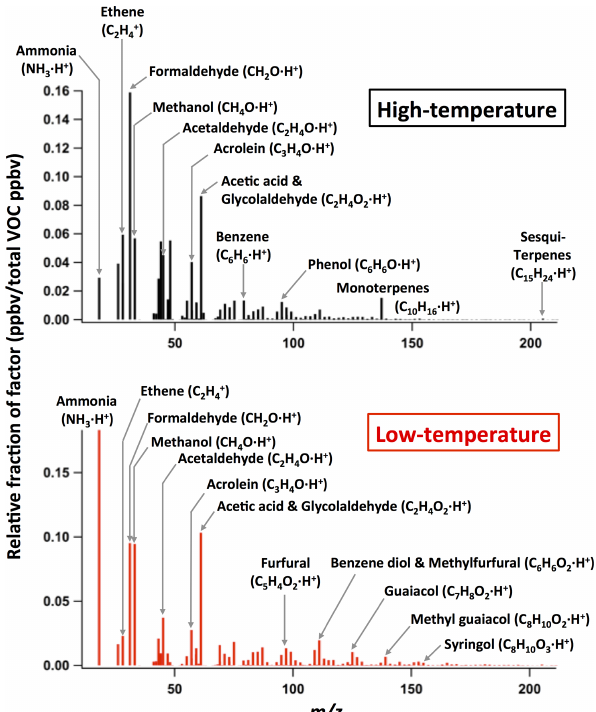
Figure 3. Average VOC emission profiles of high- and low- temperature pyrolysis factors, obtained using consolidated PMF re- sults of 15 different